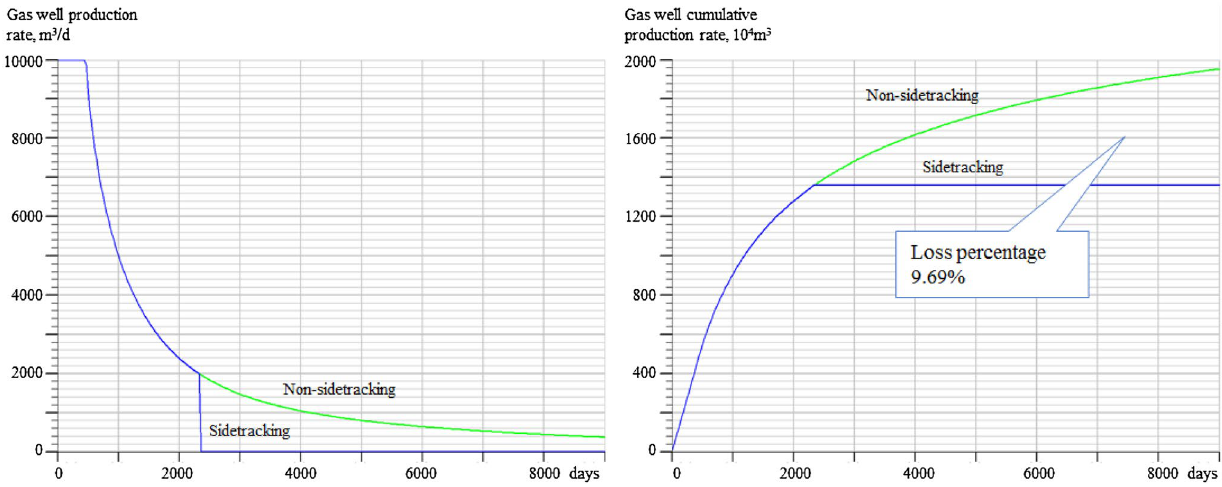
Fig. 6 Comparison of production curves between sidetracking and non-sidetracking in 2000 m 3